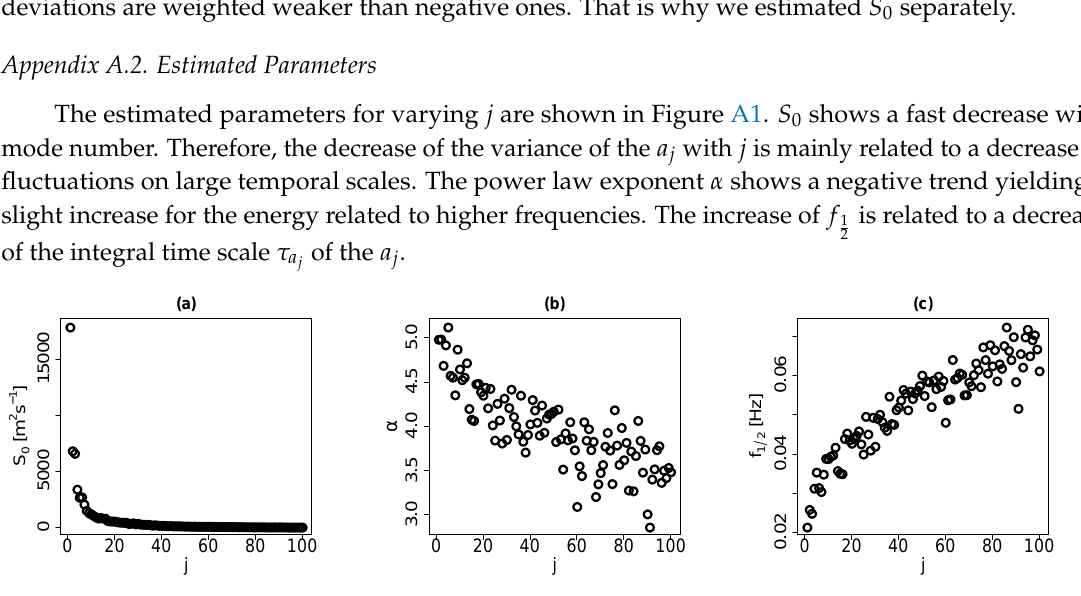
Figure A1. Estimated parameters for the spectral model versus the mode number j .